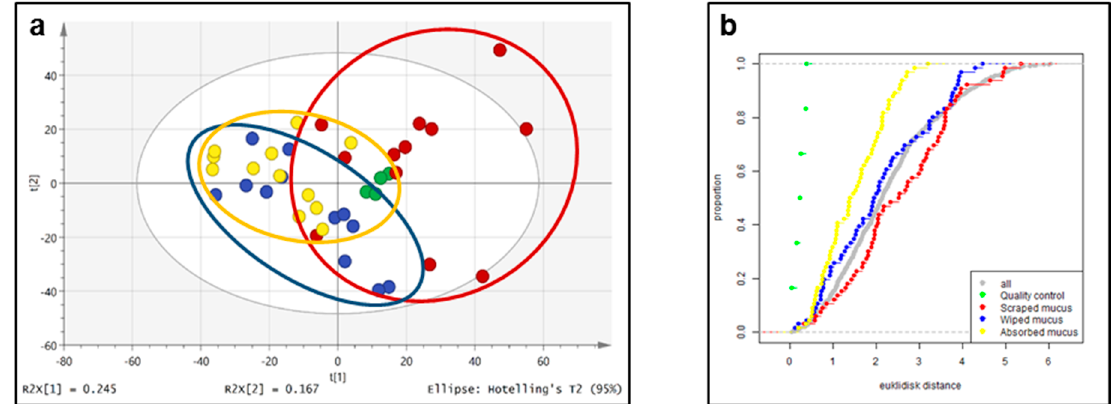
Figure 4. Score plot from PCA ( a , unit variance scaled) of the metabolite profiles obtained from untargeted LC–HRMS and corresponding Euclidic distance plot of the same data ( b ); quality control samples in green, scraped mucus samples in red, wiped mucus samples in blue, and filter absorbed mucus samples in yellow. The two first components explain 41% of the total variation.